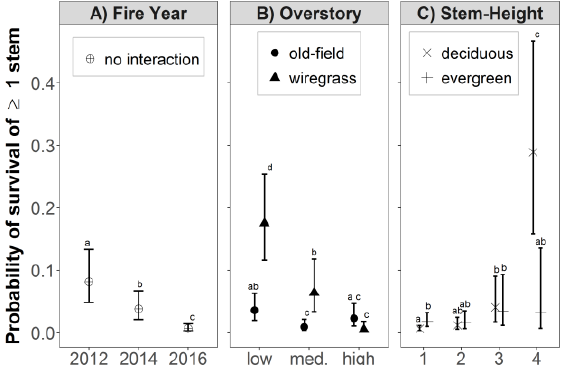
Figure 3. Probability (least-squares means with 95% confidence intervals) that ≥ 1 stem per shrub-form hardwood genet will survive biennial prescribed fire in longleaf pine woodland in SW Georgia, USA. ( A ) Effect of fire year; ( B ) Interactive effect of overstory density and groundcover composition, and ( C ) Interactive effect of pre-fire stem height class 1 (< 0.5 m), 2 (0.5 to <1 m), 3 (1 to <1.5 m), and 4 (≥ 1.5 m); and leaf habit. Within each panel, effects that do not share superscripted letters are significantly different at a 95% confidence level. Abbreviations: old-field, OF; wiregrass, WG; deciduous, decid.; evergreen, evgrn; medium, med.